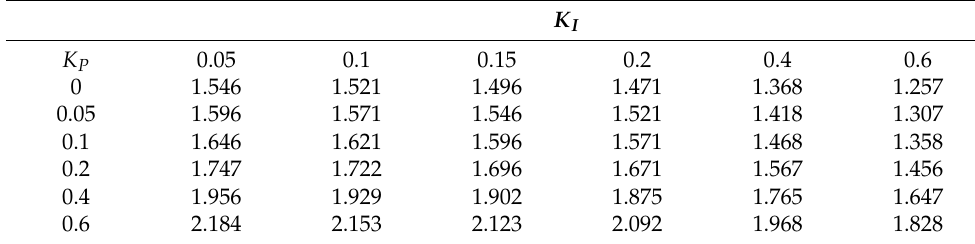
Table 2. Crossing angles, θ c , rad.